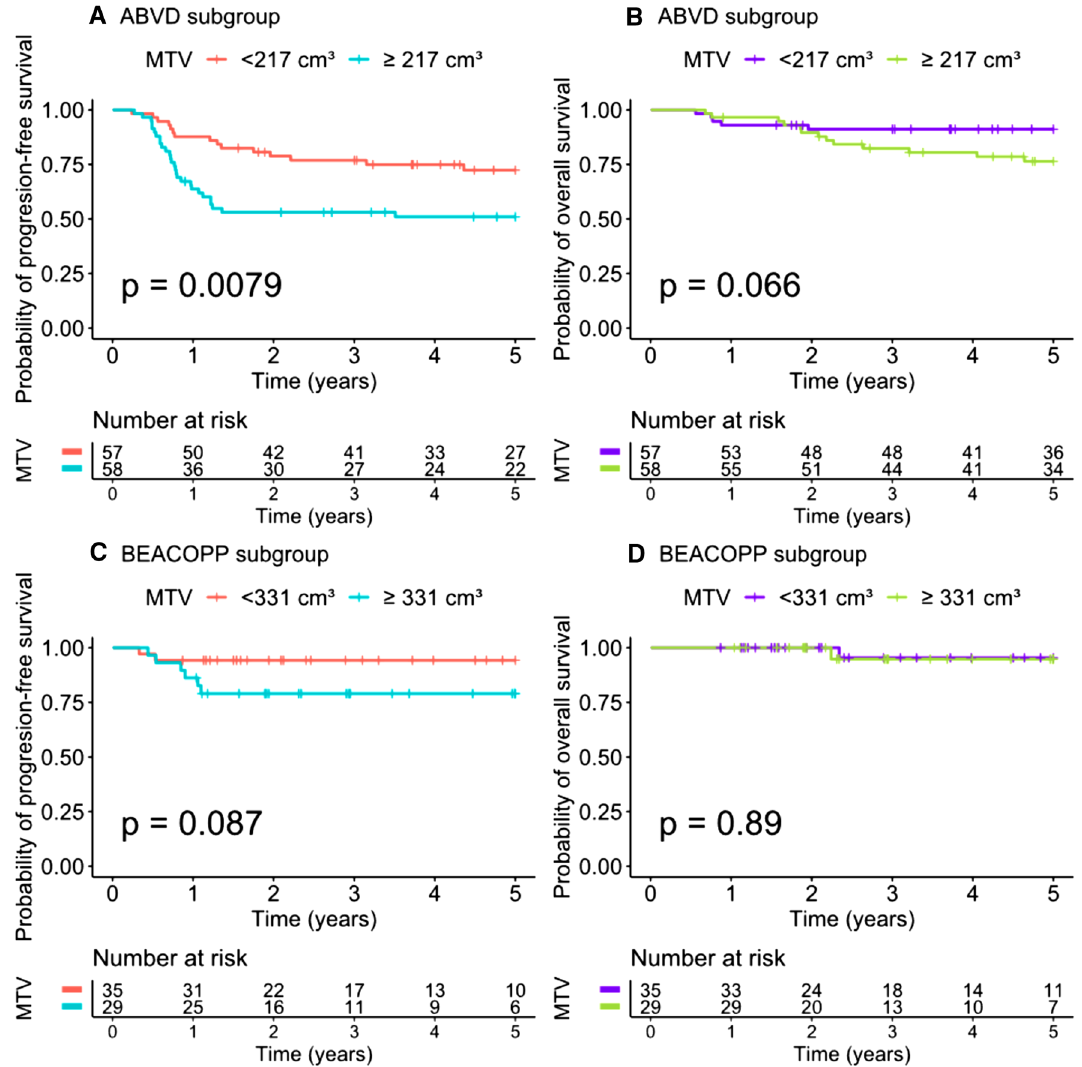
Figure 3. Kaplan Meier analysis of 5-year progression-free survival in relation to total metabolic tumour volume (TMTV) according to